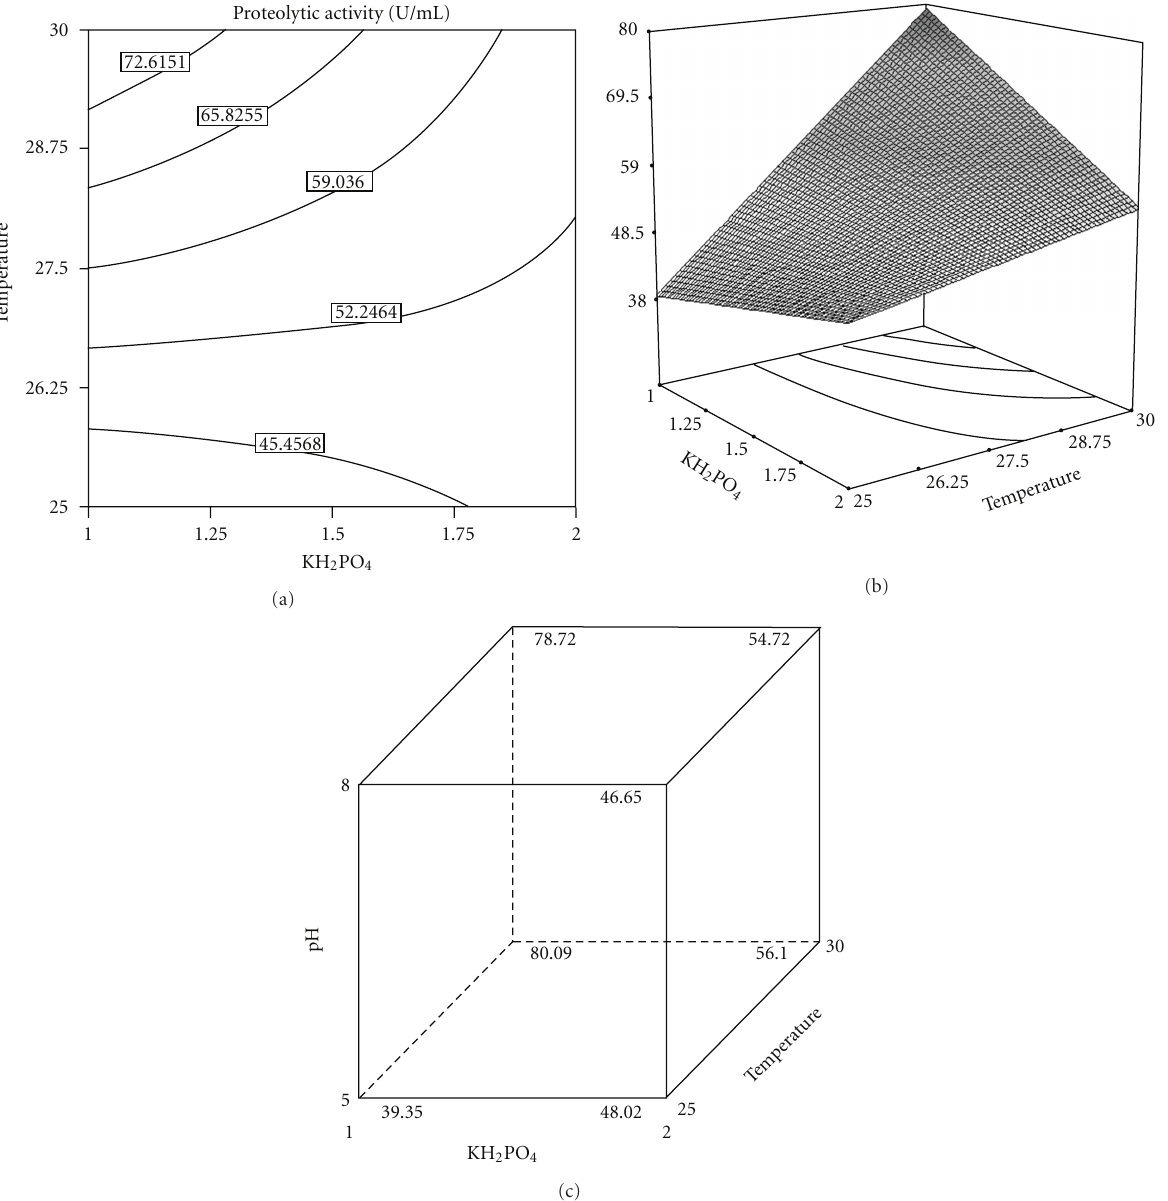
Figure 2: Response surface plot of proteolytic enzyme production showing the interactive e ff ects of the temperature and KH 2 PO 4 concentrations (a, b), and initial pH, temperature, and KH 2 PO 4 concentrations